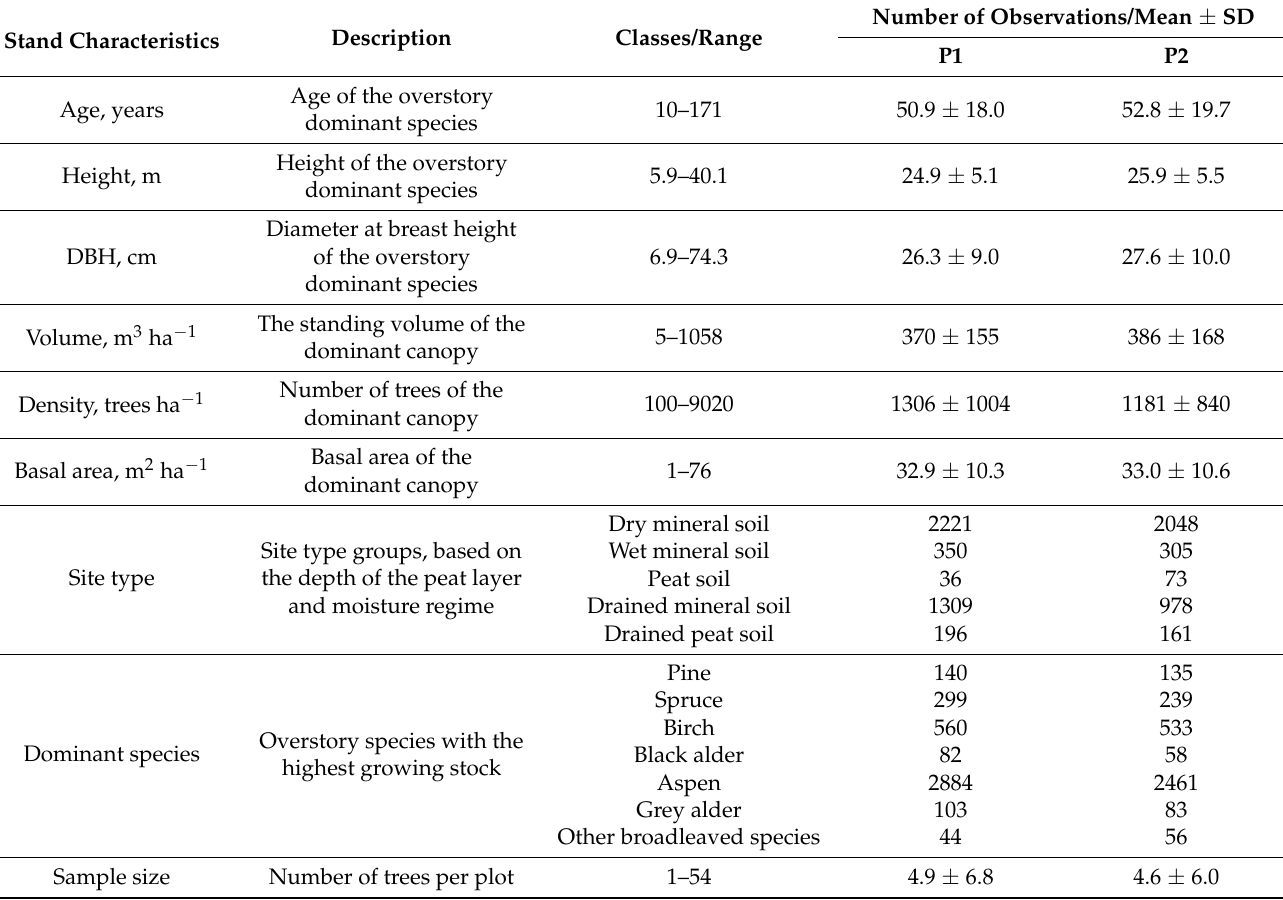
Table 1. Characteristics of sample plots. Number of observations for categorical variables, mean ± standard deviation (SD) for continuous variables. P1—a paired period of 2004–2008 and 2009–2013, P2—a paired period of 2009–2013 and 2014–2018. Stand